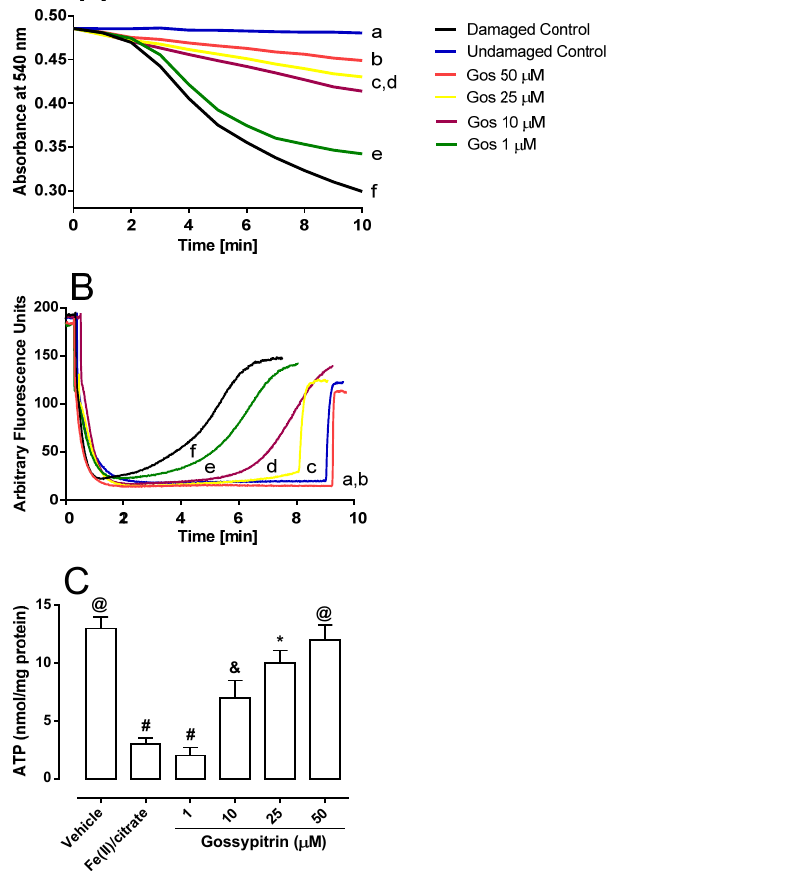
Figure 4. ( A ) Mitochondrial permeability transition induction, ( B ) mitochondrial membrane potential ( ∆Ψ ) loss, and ( C ) reduction of ATP levels induced by 50 µ M Fe(II)-citrate. ∆Ψ was estimated using the fluorescence probe safranine (5 µ M). The inhibitory effects of Gos 50, 25, 10, and 1 µ M are shown in lines (b), (c), (d), and (e), respectively. Lines (a) and (f) represent undamaged controls (without iron), and damaged controls (without Gos), respectively. Rat brain mitochondria (RBM-0.5 mg/mL), Fe(II) and 1 µ M CCCP were added where indicated by the arrows. Different symbols in graph ( C ) indicate statistical differences at p < 0.05 when comparing all pairs of experimental groups according to the ANOVA and post hoc Newman-Keuls tests. (If the symbols are different among groups indicate statistical differences, when they are equal, there is